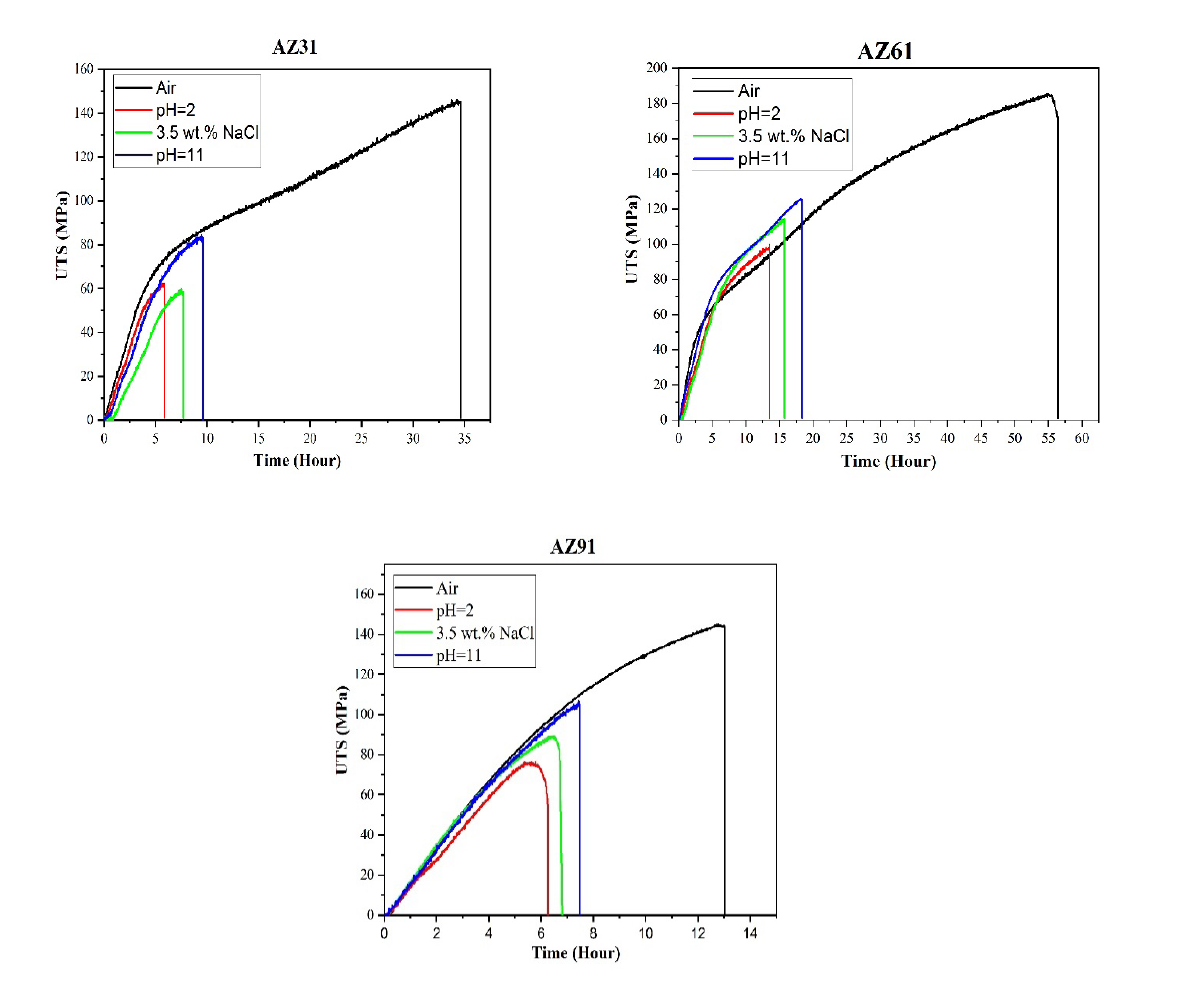
Figure 2: The fracture times of AZ31, AZ61 and AZ91 Mg alloys in air, acidic, natural (3.5 wt.% NaCl) and basic media as a result of SSRT test.